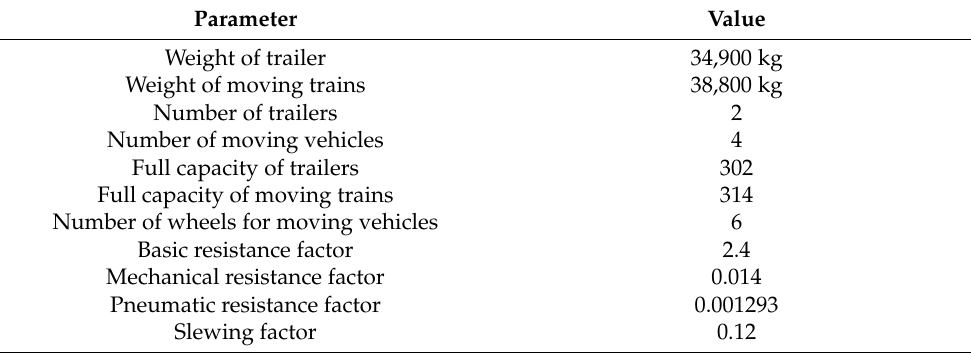
Table 1. Train simulation parameters.